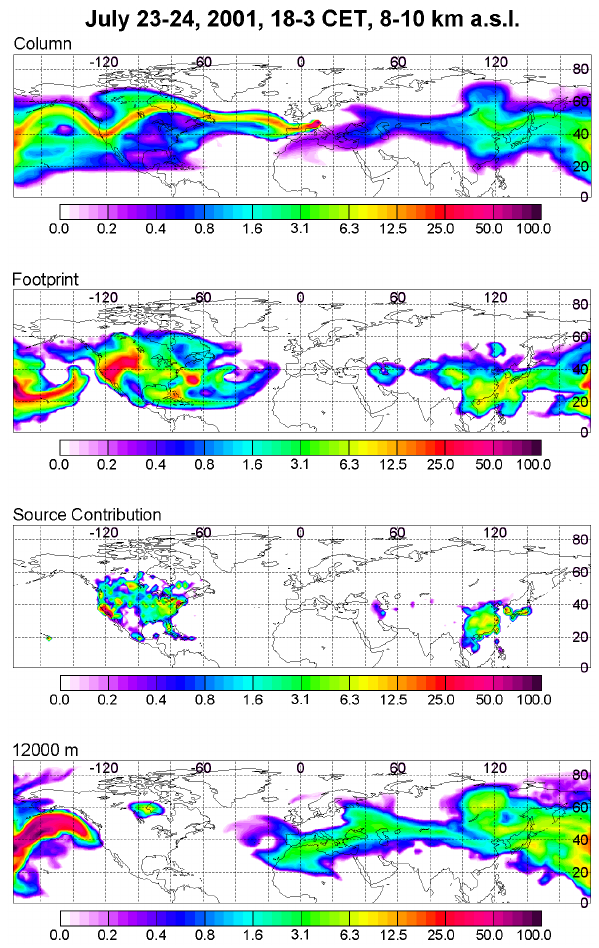
Fig. 16. FLEXPART fifteen-day backward simulation for retro- plumes released between 23 July 2001, 18:00CET, to 24 July 2001, 03:00CET, and between 8 and 10kma.s.l. above Garmisch- Partenkirchen (Layer 3 in Fig. 13; see Fig. 2 for more details).